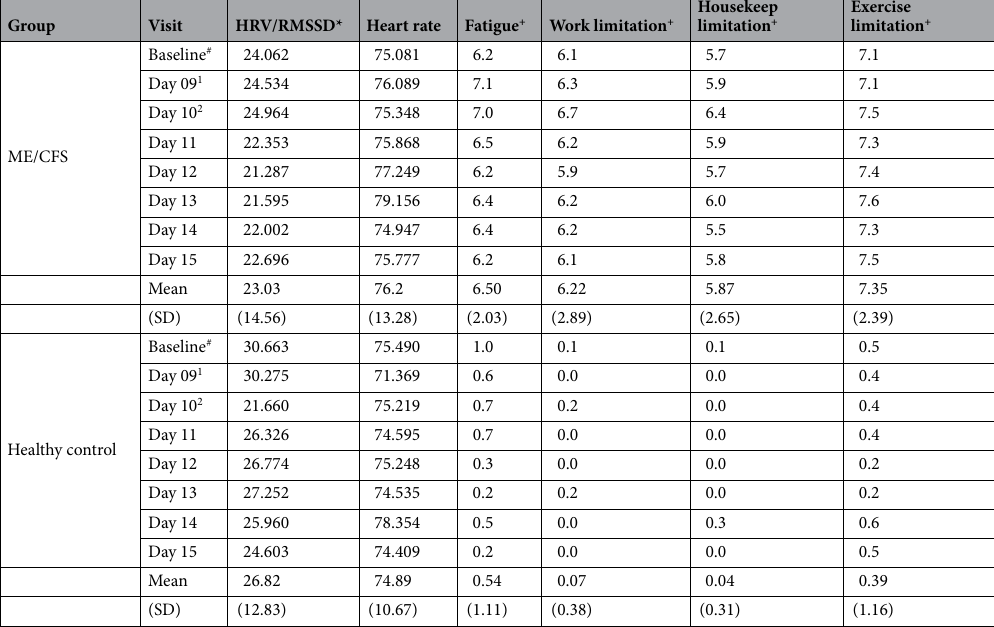
Table 4. Average heart parameter values and self-report fatigue and functional limitation ratings (0–10) from baseline to Day 15 for ME/CFS and healthy control groups. *Heart rate variability/root mean square of the standard deviation. + Ratings (0–10). # Baseline is the average value from Day 1 to Day 8 (pre-walk test). 1 First six-minute walk test. 2 Second six-minute walk test; Standard deviations are in